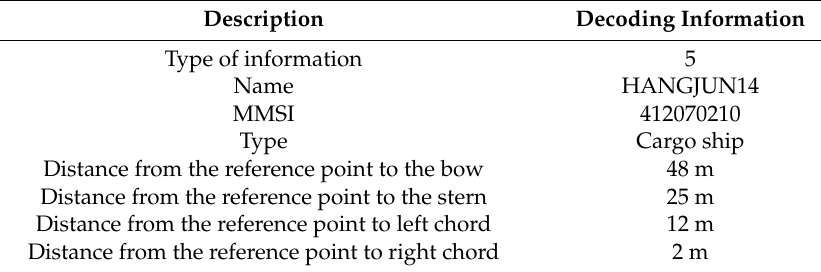
Table 3. The decoding results of the vessel’s static